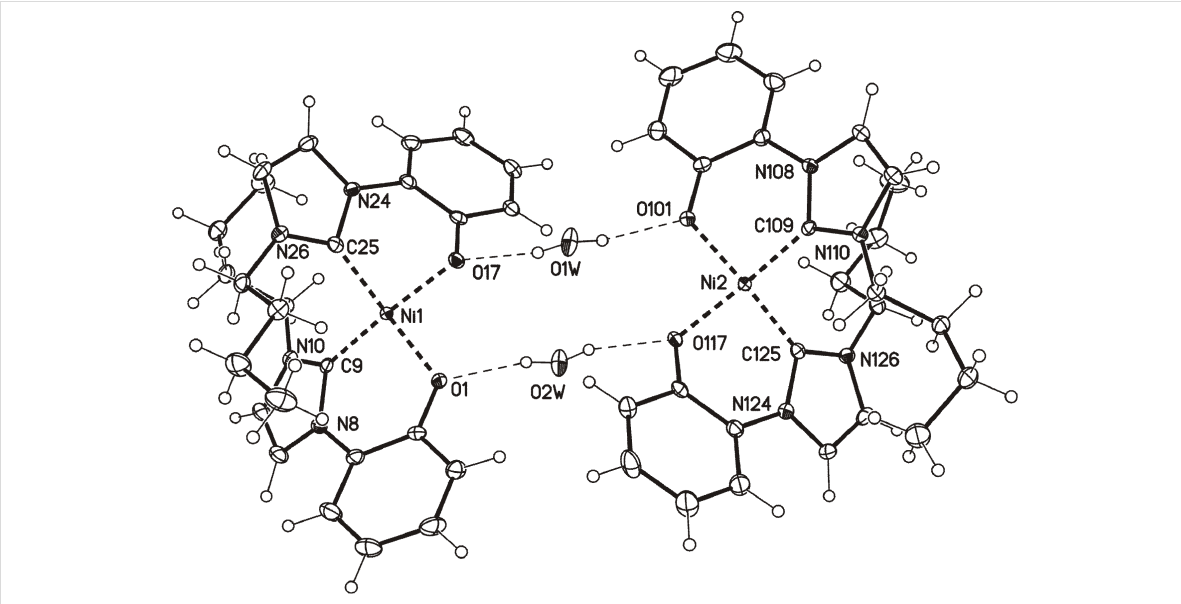
Figure 5: Molecular drawing of the dimeric nickel complex 12 (displacement parameters are drawn at 50% probability level; crystallographic number- ings).